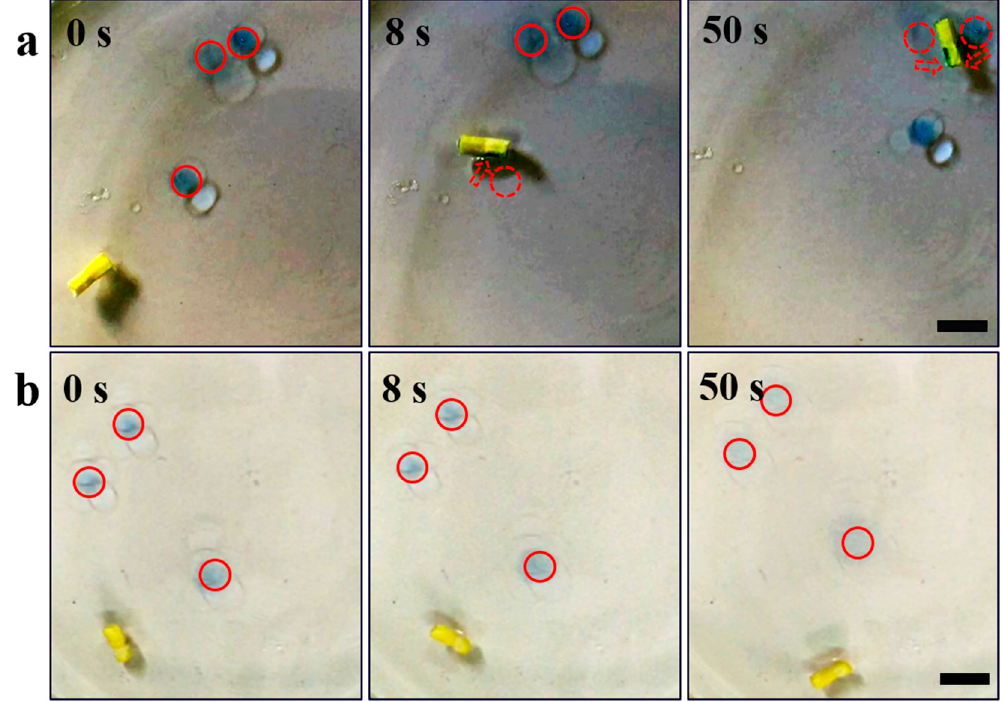
Figure 4. The capture of oil droplets by ( a ) a Janus foam motor and ( b ) an immobile SA-PVA foam at 0, 8, and 50 s, respectively, revealing that the Janus foam motor exhibits a much higher oil absorption efficiency than that of the immobile foam. Scale bars: 10 mm.